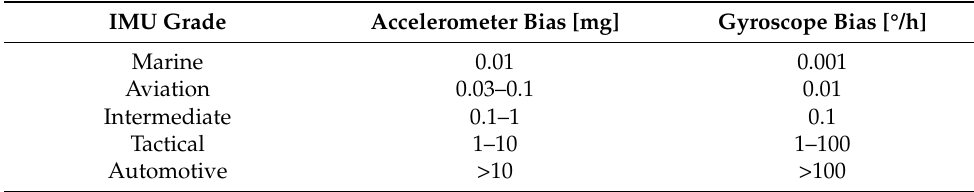
Table 2. Typical inertial sensor biases according to IMU